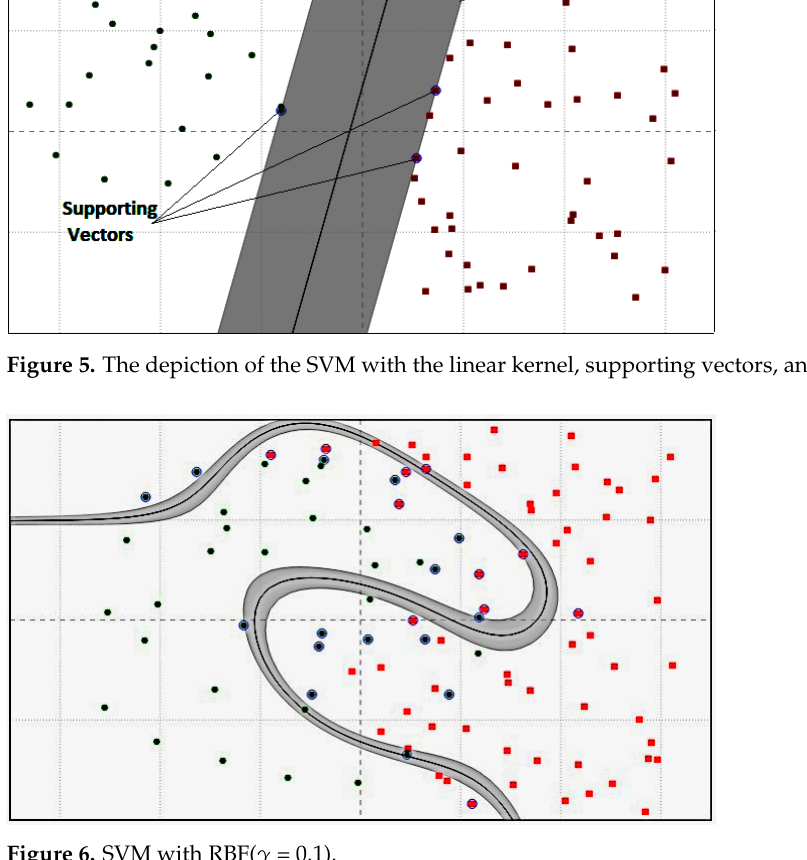
Figure 6. SVM with RBF( γ = 0.1).